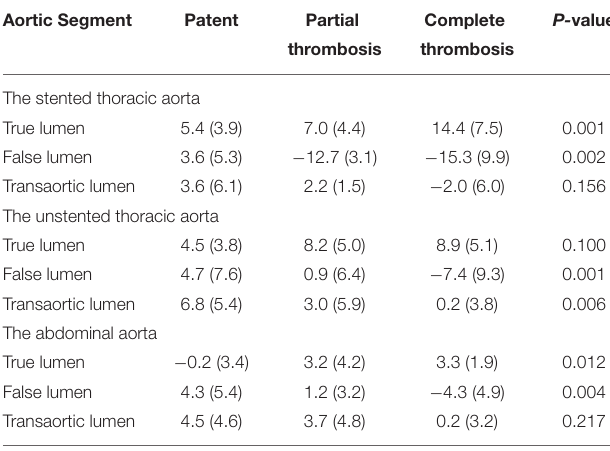
TABLE 5 | Changes in the maximum diameters of the TL, FL, and total lumen (transaortic) in the stented thoracic aorta, unstented thoracic aorta, and abdominal aorta according to FL